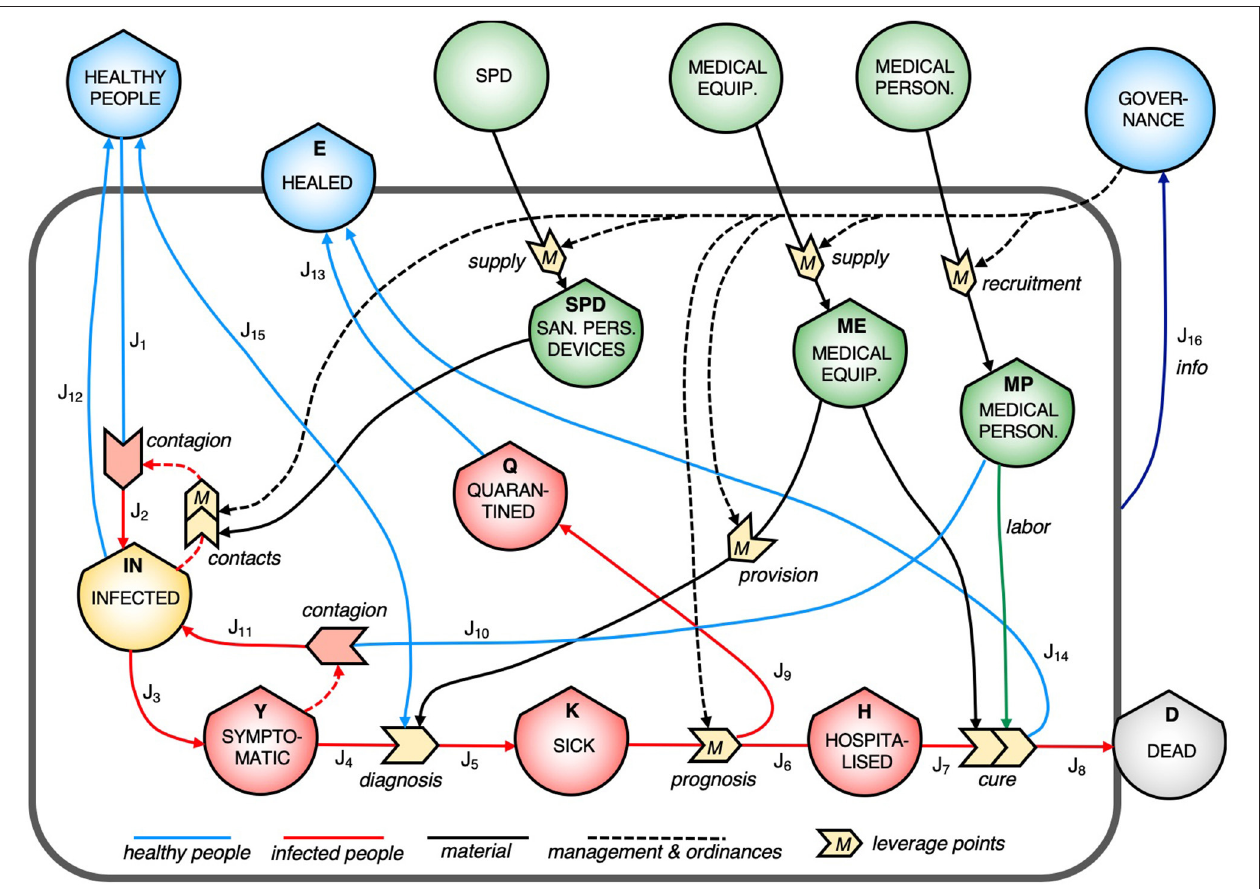
FIGURE 1 | Systems Thinking stock-flow diagram for the COVID-19 epidemic description. Stocks (shield symbols) are: IN, infected people whitout symptoms; Y, infected with symptoms; K, diagnosed sick people; Q, people in quarantine; H, hospitalized people; D, dead people; E, healed people (returned to normal); SPD, sanitary personal devices (face masks, gloves, disinfectant); ME, medical equipment (including swabs, test kits, personal protective equipment, and intensive care equipment, especially mechanical ventilators and oxygen). Blue and red arrowed lines (labeled with J for subsequent mathematical representation) are the flows of people in the system, that in turn define day by day the value of the people stocks and the systemic state of the system. Solid black lines are the flow of resources needed to take on the epidemic, with the green line representing the medical personnel labor. Dashed black lines indicate the governance measures implemented to face the crisis. From a systemic point of view, they are flows of information or services. Big arrowed symbols are the processes, labeled with “M” wherever they could represent an effective leverage point for intervention. Colors are: blue for healthy people and governance, red or yellow for infected people, and green for generic systemic